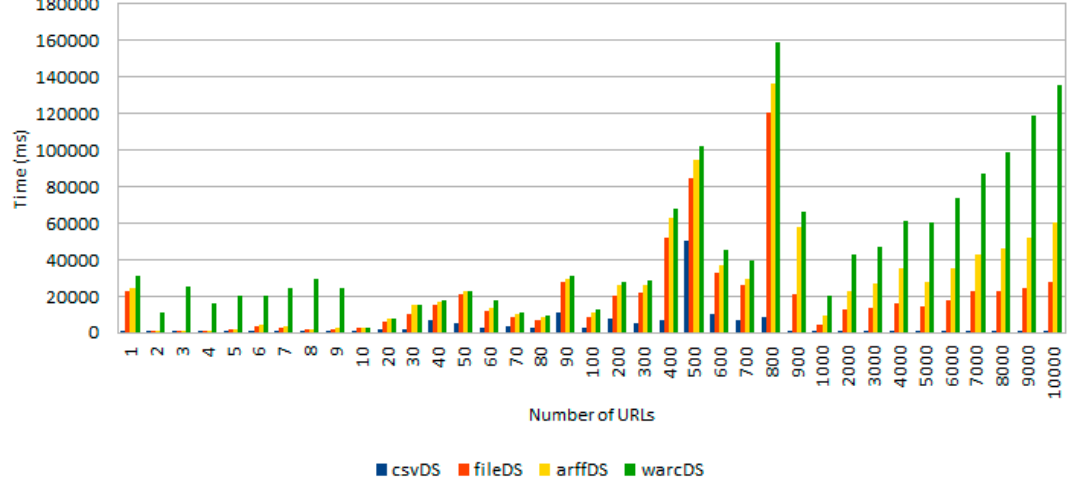
Figure 9. Time required to accomplish the initial phase comprising the retrieval of a variable number of URLs from different data sources.